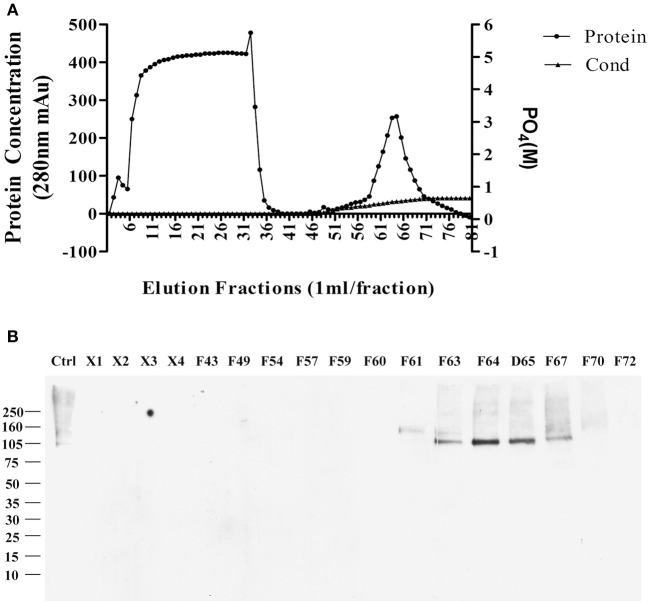
Further enrichment of AβO binding protein p100 by CHT Cartridge HPLC. Fractions from the sucrose gradient containing the highest amount of p100 (fractions 14 and 15) were treated with SDS and 1 h at 100,000 g. Filtered supernatant were applied to CHT-column and fractions washed from the column by linear gradient sodium phosphate (10–700 mM). (A) Relative protein abundance in fractions determined by absorbance and by conductance. (B) Selected fractions assayed for presence of endogenous AβO binding protein p100 by ligand blotting. Proteins in fractions X1–X4 did not bind to column and showed no AβO binding proteins. Fractions containing p100 (F63–65) were collected and dialyzed against 10 mM Trit-HCl pH 7.4, and concentrated by ultrafiltration for LC-MS/MS.